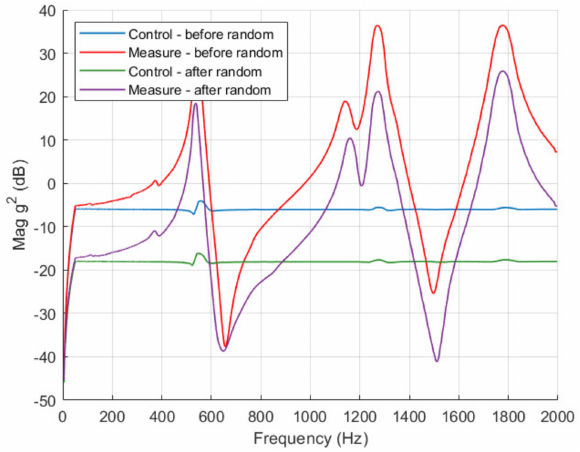
Figure 9. Resonances before and after tests on z axis, AA 6081